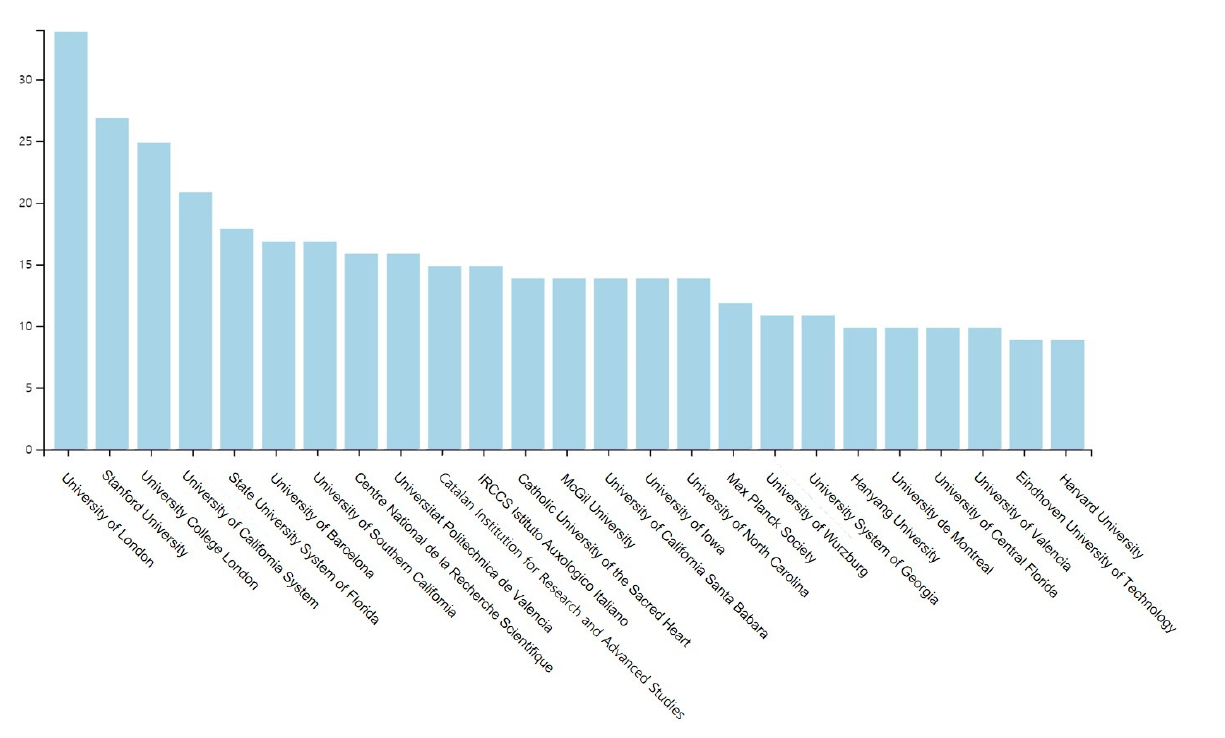
Figure 5. Most prolific affiliations. Table 6. The top 10 most prolific affiliations.